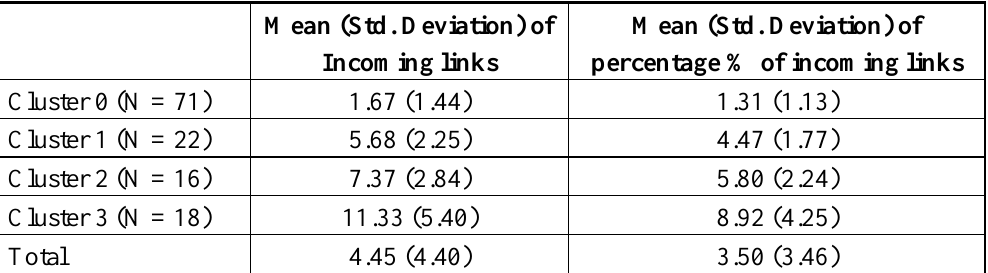
Table 1. Incoming links of the